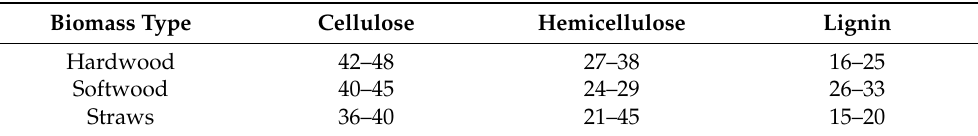
Table 1. Composition of woody biomass in comparison with straws (wt% dry basis) [42].